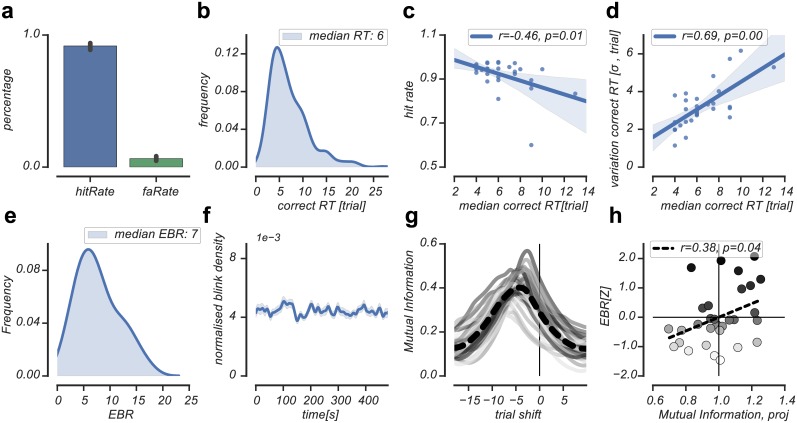
Behavioral and EBR data.(A): Average hit rate and false alarm rate across subjects (B): Response time distribution of correctly detected reversals across subjects. (C): Relation between the hit rate and correct reversal detection time. (D): Relation between correct reversal detection time and detection time variability. (E): EBR distribution across subjects. (F): Blink density across a run of 8 minutes averaged across subjects. (G): Mutual information (MI) between experimental and reported reversals plotted as a function of time-shifts in the reported reversals. Across subjects, shifting the reported reversals 5 trials back towards the experimental reversal (at trial shift = 0) resulted in the highest MI estimate (dashed line). Time units on x-axis are trials. Solid lines reflect individual MI estimates, colored by individual EBR rank (low EBR = light gray, high EBR = dark gray). (H): Individual MI estimates projected on the average MI estimate were positively related to EBR, indicating that individuals who detected reversals more consistently across runs had relatively higher EBR (low EBR = light gray, high EBR = dark gray).